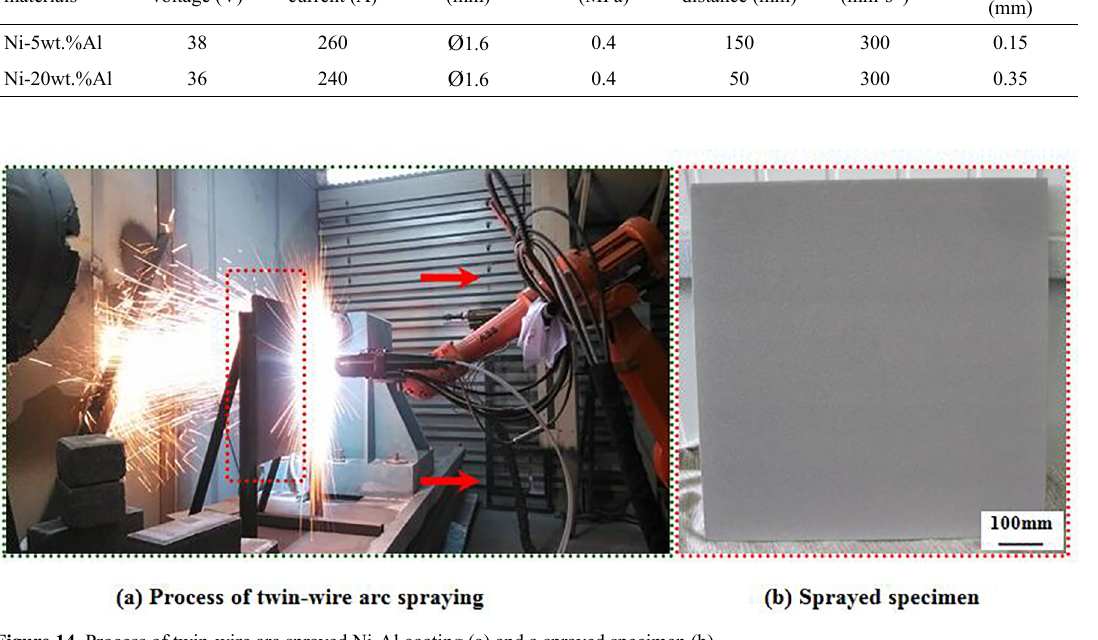
Figure 14. Process of twin-wire arc sprayed Ni-Al coating (a) and a sprayed specimen (b)